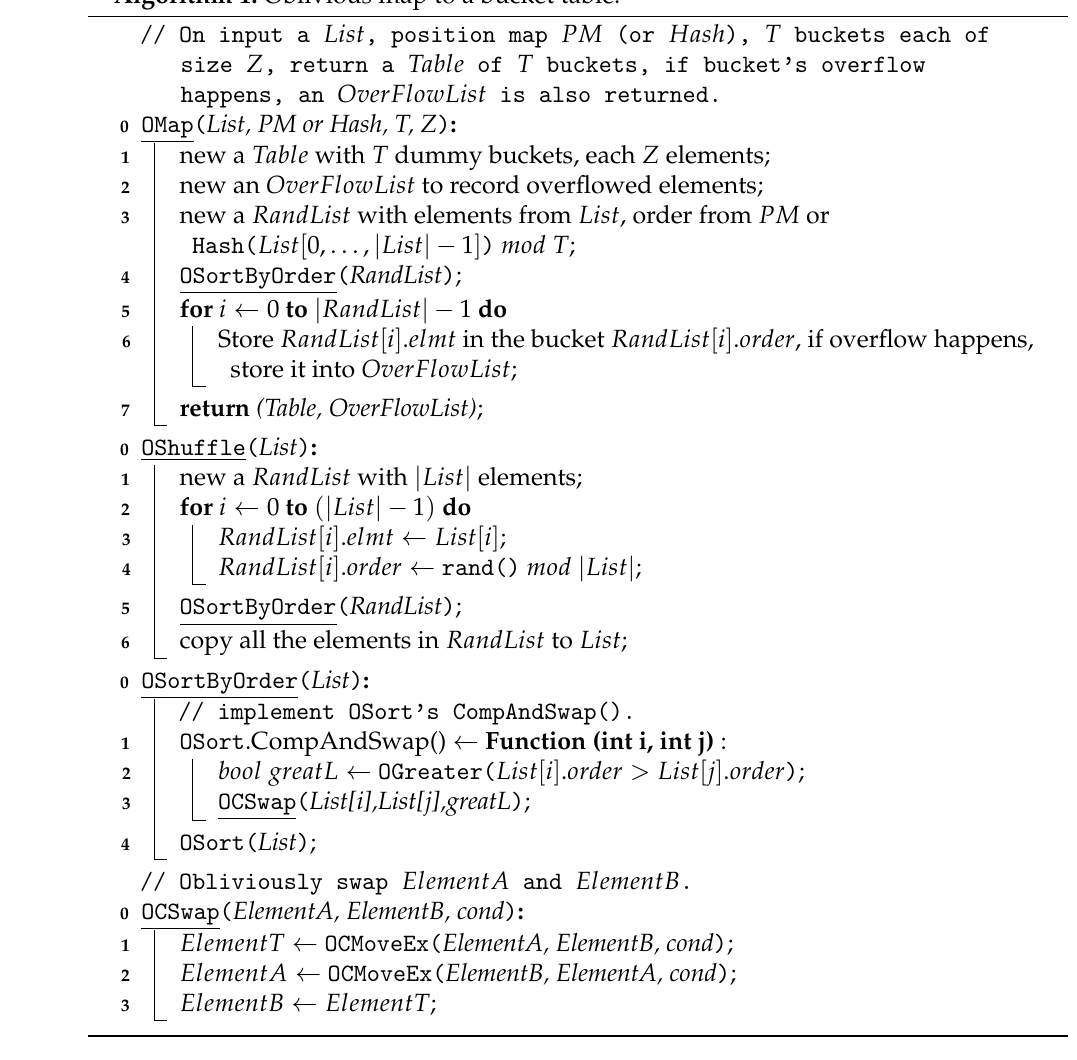
Algorithm 1: Oblivious map to a bucket